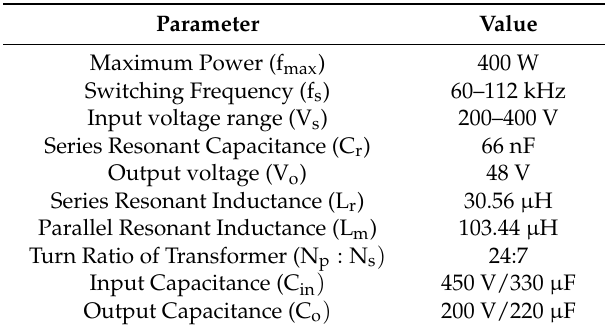
Table 3. Specification of designed LCC converter for